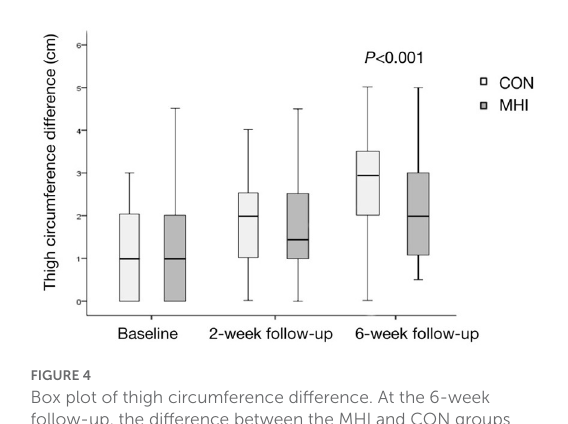
FIGURE4 Box plot of thigh circumference difference. At the 6-week follow-up, the difference between the MHI and CON groups was statistically significant ( P < 0.001). The difference in thigh circumference was more negligible in the MHI group, implying better rehabilitation.